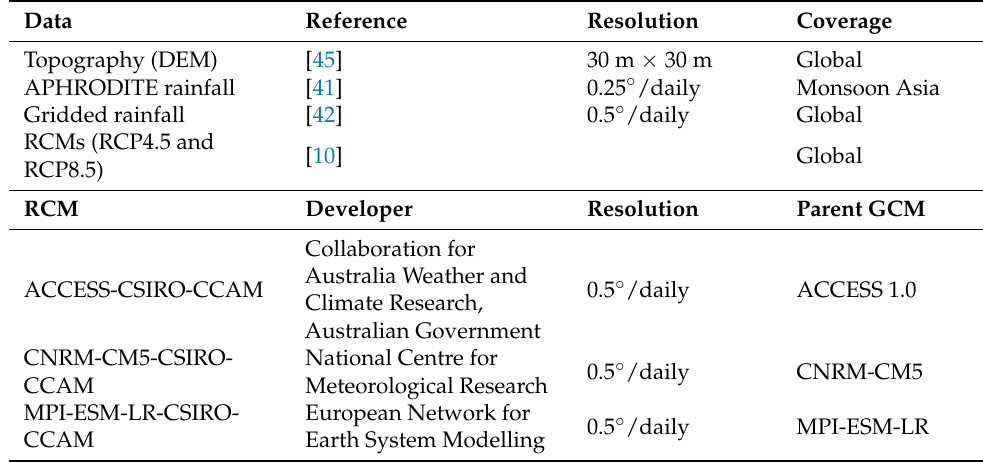
Table 2. Temporal and spatial datasets used in the